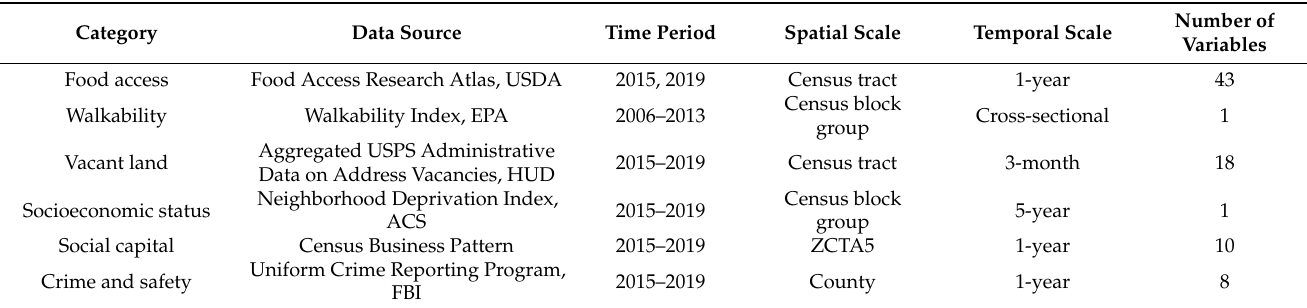
Table 1. Summary of contextual-level SDoH